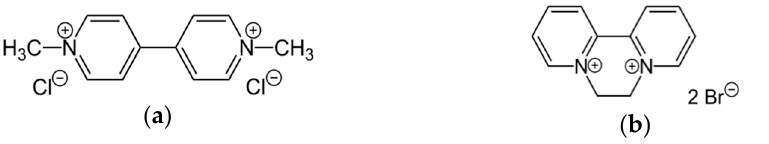
Figure 1. Molecular structures of ( a ) paraquat (PQ) and ( b ) diquat (DQ) herbicides [1]. Quat herbicides have high soil adsorption coefficients, suggesting the presence